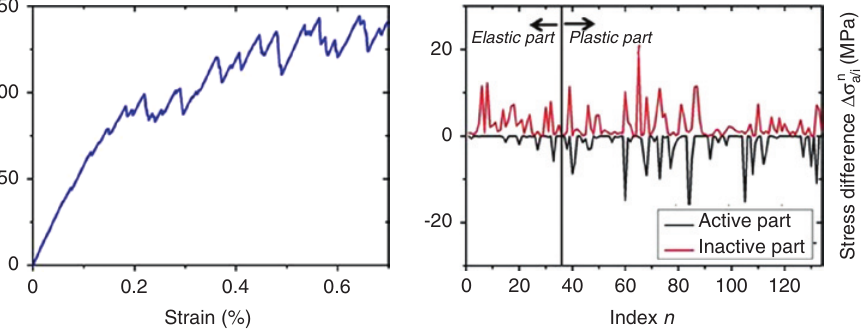
Figure 8: Left: Stress-strain curve of a single DDD simulation. Right, black line: stress difference during the active part of an active-inactive cycle vs. cycle number n ; red line: stress difference during inactive part vs. cycle number n